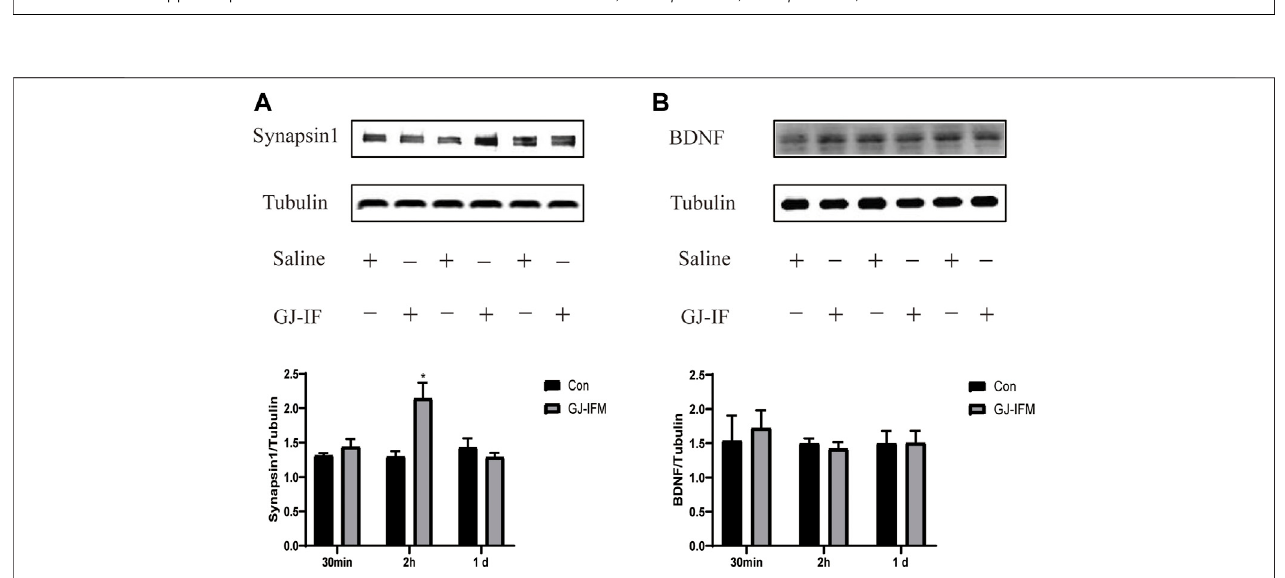
FIGURE10| GJ-IFM drasticallyenhancedexpressionofsynapticproteinsynapsin1butnotBDNF. (A) Theexpressionofsynapsin1increasedat2 hafterGJ-IFM administration; however, there was no signi fi cant change at 30 min and 1 d. t -test, 30 min: p > 0.05, 2 h: * p < 0.05, 1 d: p > 0.05; control vs . GJ-IFM. (B) There was no signi fi cant escalation in BDNF protein expression at 30 min, 2 h, and 1 d. t -test, 30 min: p > 0.05, 2 h: p > 0.05, 1 d: p > 0.05; control vs . GJ-IFM.